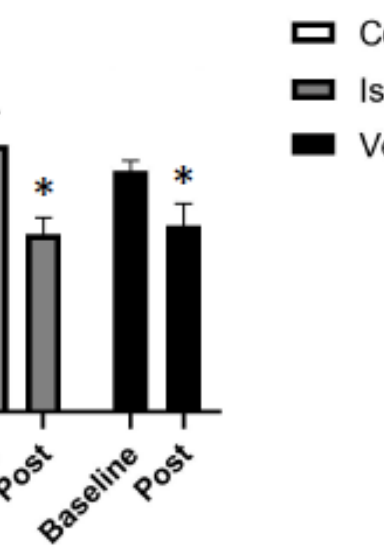
Figure 3. Oxidative stress-sulfhydryl. Sulfhydryl: η mol of total bound nitrogen (TBN)/mg of protein; * p < 0.05, significantly different from baseline.